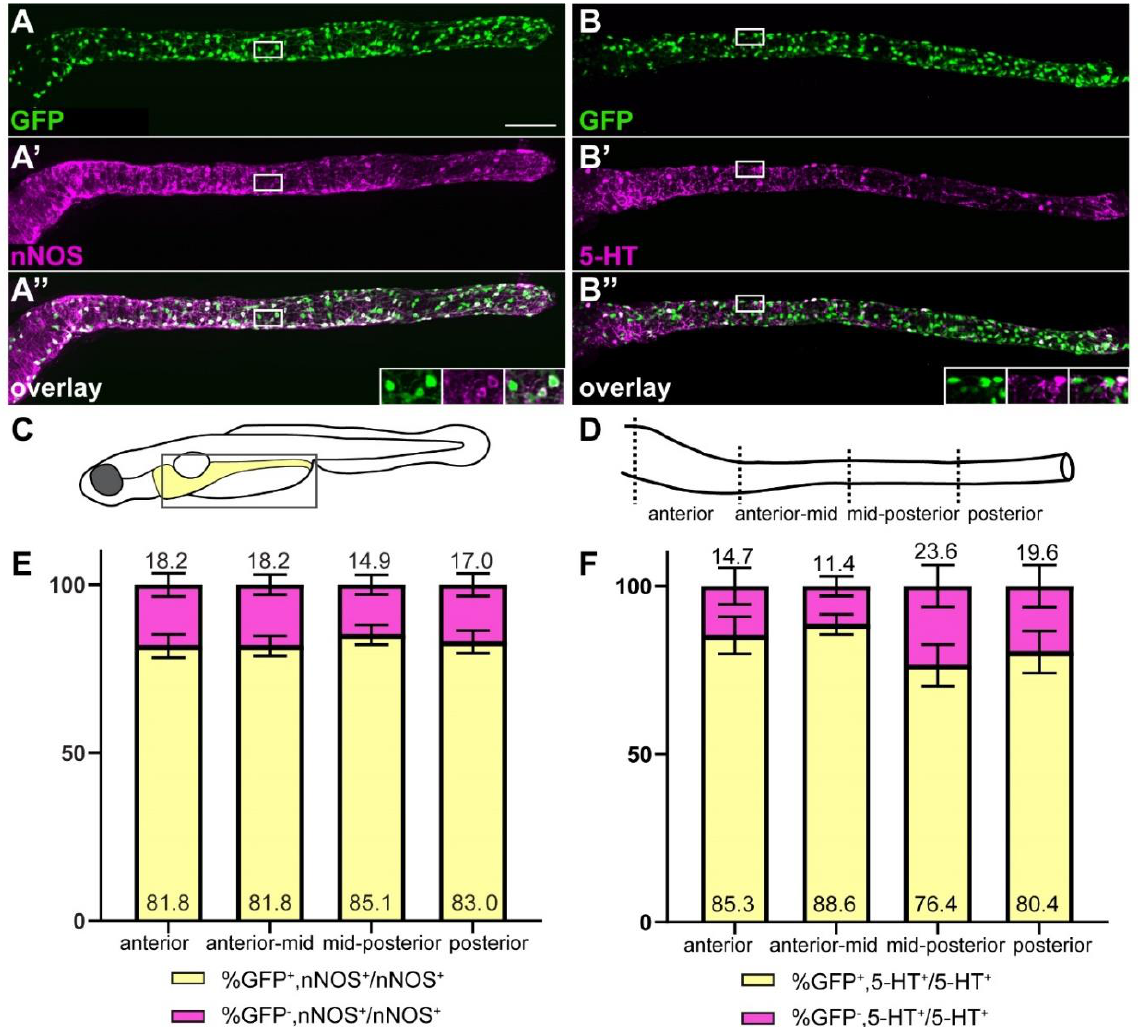
Figure 4. The majority of nitrergic and serotonergic neurons are GFP + . ret:GFP is expressed in the majority of nitrergic ( A – A’’ ) and serotonergic ( B – B’’ ) neurons (white). Insets in ( A’’ , B’’ ) show close-up of the boxed area, GFP, nNOS or 5-HT, and overlay from left to right. Schematic of boxed area of larval schematic ( C ) indicates the four gut sub-regions analyzed ( D ). ( E ) Quantification of GFP and nNOS colocalization in four gut regions as shown in ( D ). Bar graph shows % GFP + /nNOS + out of total nNOS + cells (yellow), and % GFP − /nNOS + out of total nNOS + cells (magenta). Error bars show ± standard error of the mean (2 experiments, 23 larvae). ( F ) Quantification of GFP and 5-HT colocalization in four gut regions shown in D. Bar graph shows % GFP + /5-HT + out of total 5-HT + cells (yellow), and % GFP − /5-HT + out of total 5-HT + cells (magenta). Using 2-way ANOVA, we did not find significant differences between the cell population of the different gut regions. Error bars show ± standard error of the mean (2 experiments, 22 larvae). ( A – A’’ , B – B’’ ): maximum projections of dissected guts. Scale bar = 100 µm.